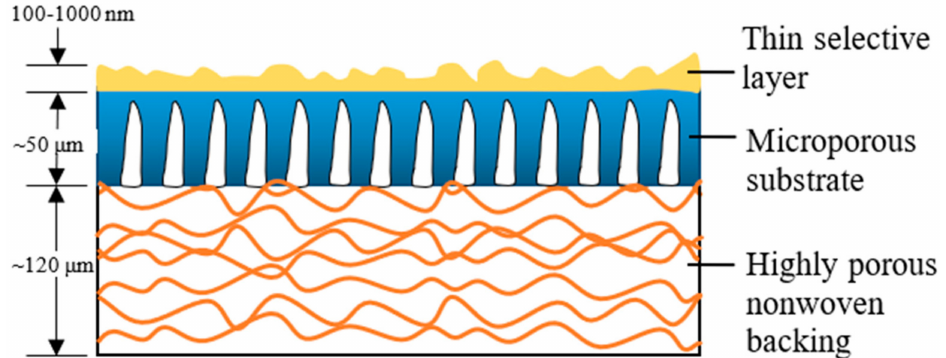
Figure 1. Schematic cross-section of a thin film composite (TFC) membrane and typical characteristics of each